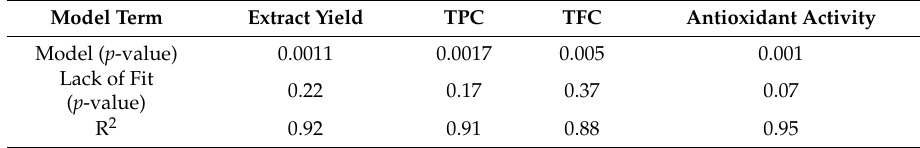
Table 3. Statistical parameters of central composite rotatable design of response surface methodology (RSM).